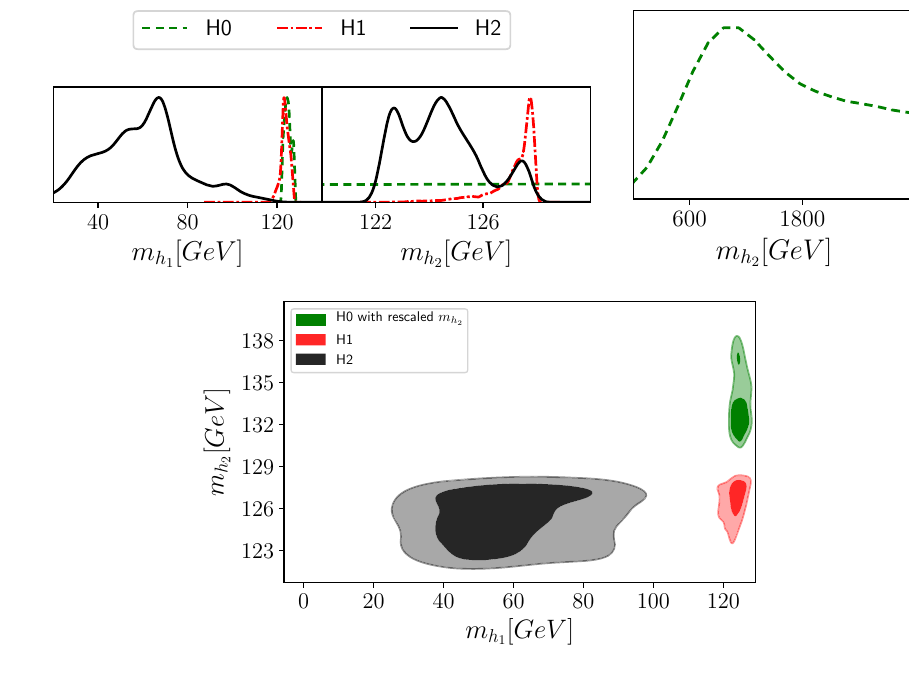
Fig. 1 Marginalised one- (top) and two-dimensional (bottom) posterior distributions for the first-two lightest CP-even Higgs bosons. The dashed/green ( H 0), dash-dotted/red ( H 1) and solid/black ( H 2) lines represent respectively the hypotheses H 0 , H H 1 and 2 . The top-right plot shows the m h distribution for 2 H 0 which is not visible on the top-left plot. For the plot on the bottom, m h for H 0 scenario 2 ( H 0, on the legend) is